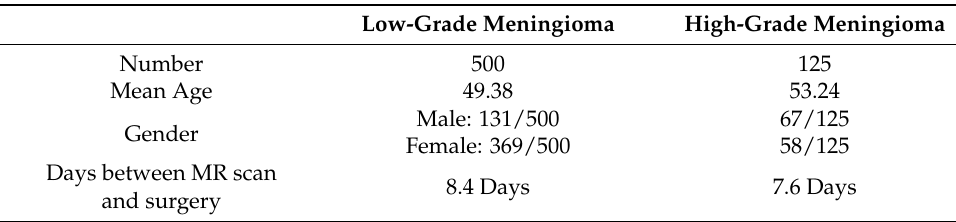
Table 1. Characteristics of patients involved in the experimental